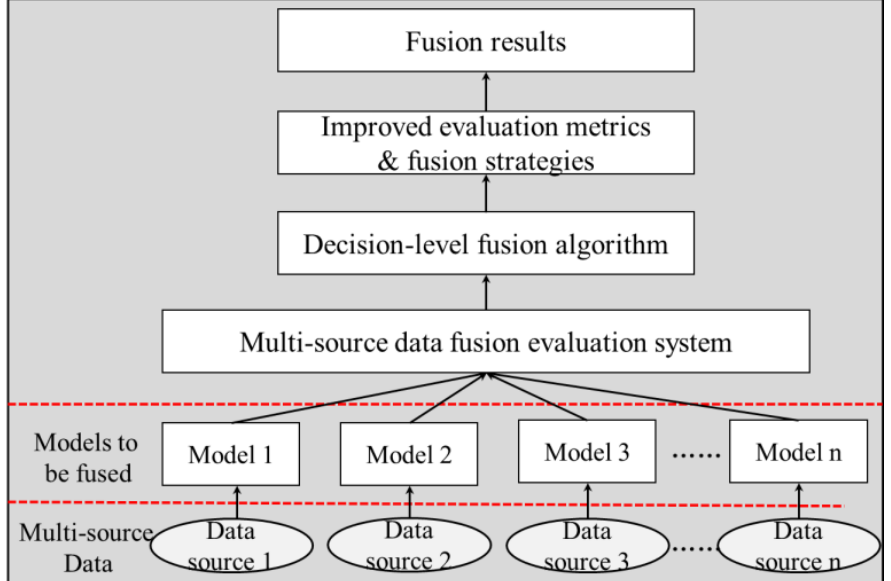
Figure 3. The fusion process of a multi-source data fusion evaluation